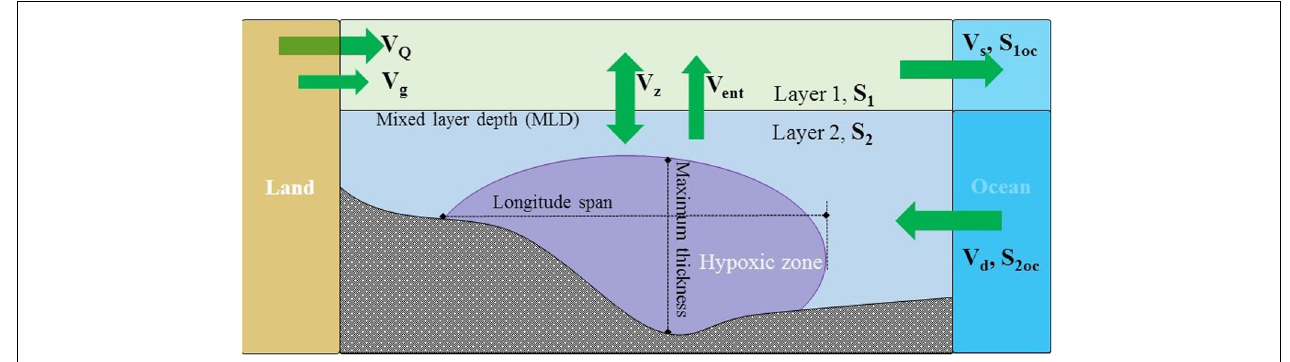
FIGURE 1 | A conceptual model for the dimension of sectional hypoxia area and water and salt budget. V Q , volume of Changjiang River runoff; V g , volume of groundwater runoff; V z , vertical exchange volume between layer 1 and 2; V ent , volume of advection-induced entrainment; V s , surface advective outflow volume from layer 1; V d , deep advective inflow volume to the layer 2; S 1 , salinity of layer 1; S 2 , salinity of layer 2; S 1oc and S 2oc , are oceanic endmember salinities of layer 1 and 2, respectively.